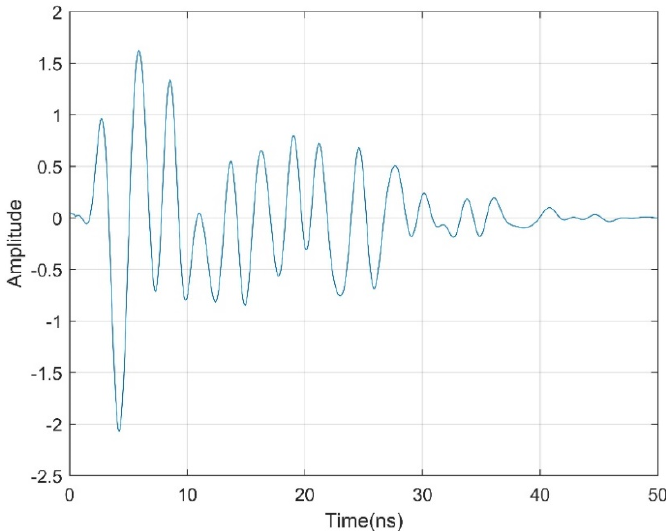
Figure 5. The averaged trace from pre − processing GPR data.